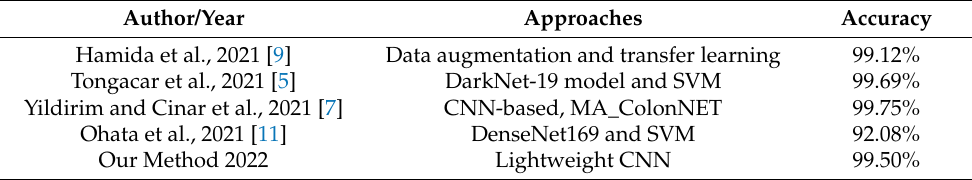
Table 3. Comparison between our deep model and other previous methods on histopathological